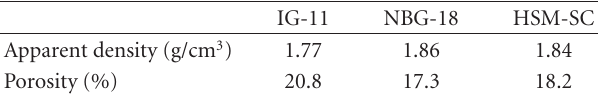
Table 2: The apparent density and porosity of the three graphite samples.